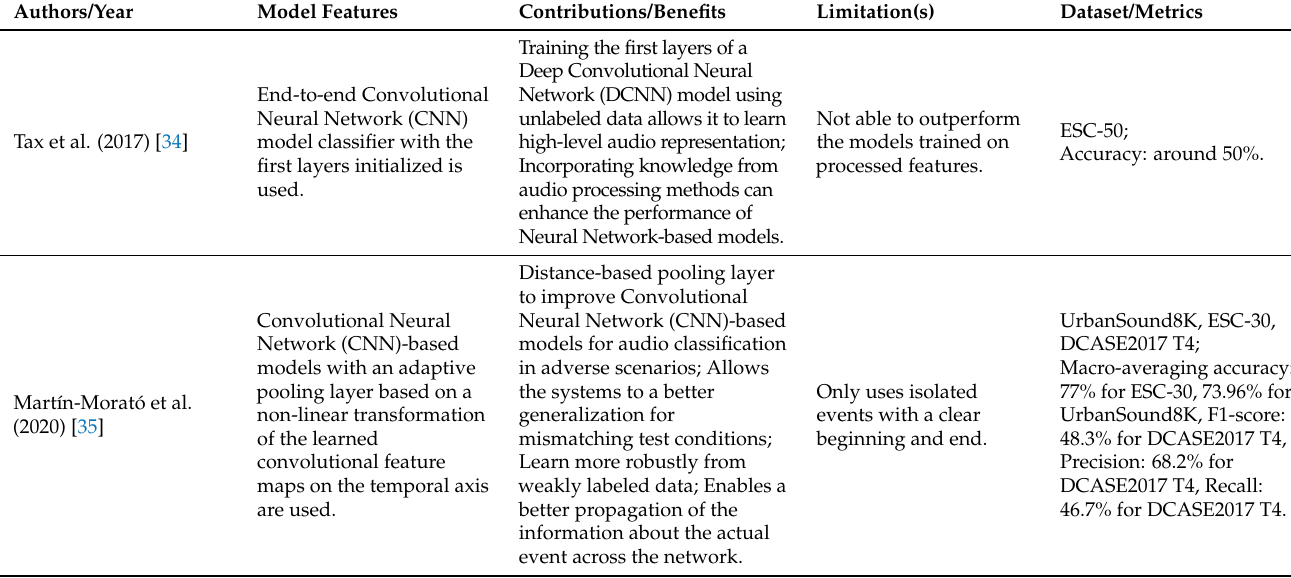
Table 3. Resume of the research articles found on audio processing with segmentation based on models or/and handcrafted